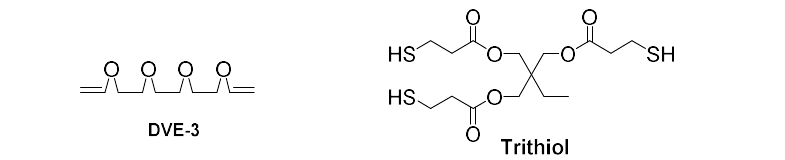
Figure 10. Chemical structures of Cu-21 – Cu-26 .